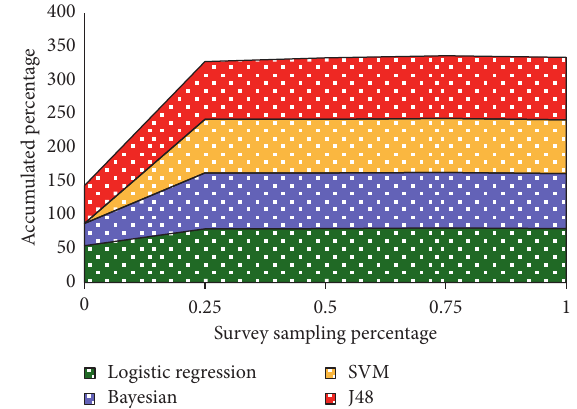
Figure 7: Comparison of accuracy (prediction without risk).